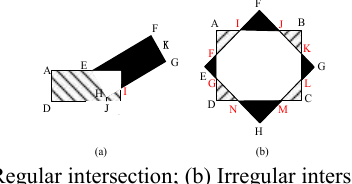
Fig.5 the IoU calculation in the rotated box